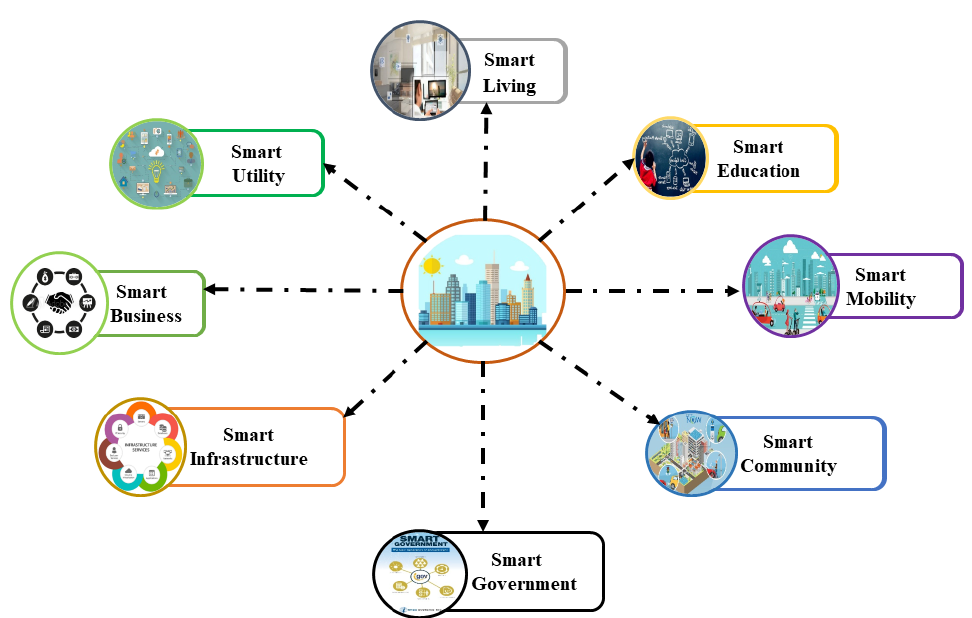
Figure 1. Smart cities main